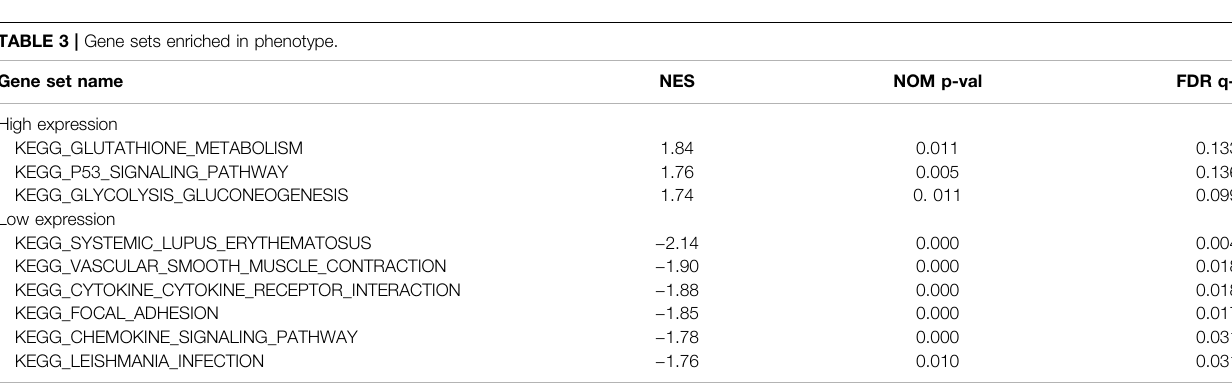
TABLE 3 | Gene sets enriched in